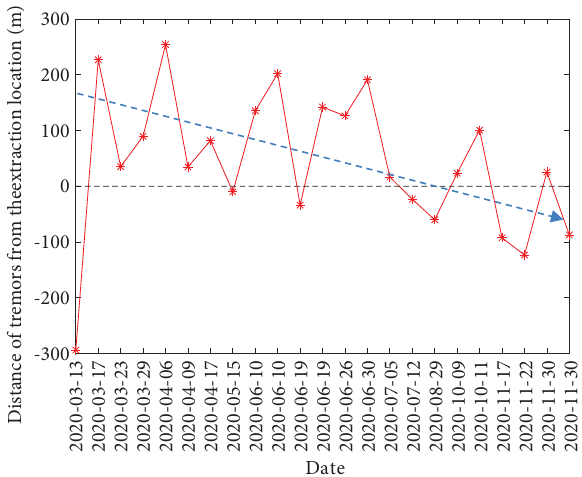
Figure 10: Te curve of strong mine tremors relationship with extraction